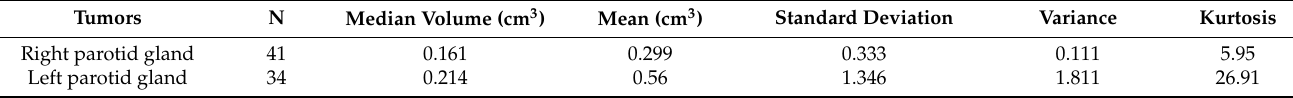
Table 3. Intraglandular tumors in 68